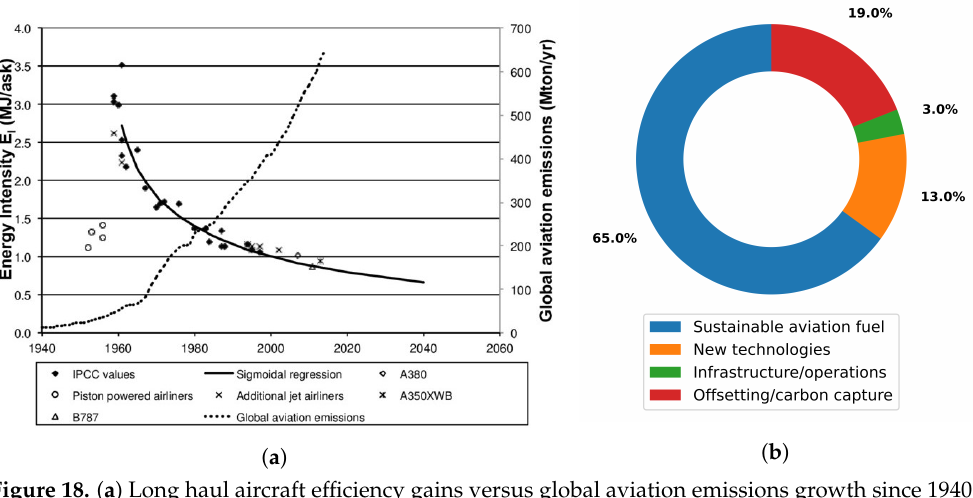
Figure 18. ( a ) Long haul aircraft efficiency gains versus global aviation emissions growth since 1940 and projected to 2040. Reprinted with permission from Peeters et al. [173]. Copyright 2022, Pergamon. ( b ) IATA Net Zero 2050 contributions. Data derived from